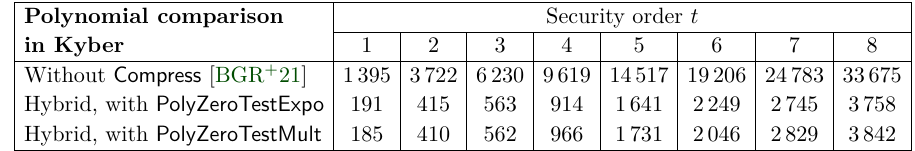
Table 10: Running time in thousands of cycles for a C implementation on Intel(R) Core(TM) i7-1065G7, for the three methods considered in Table